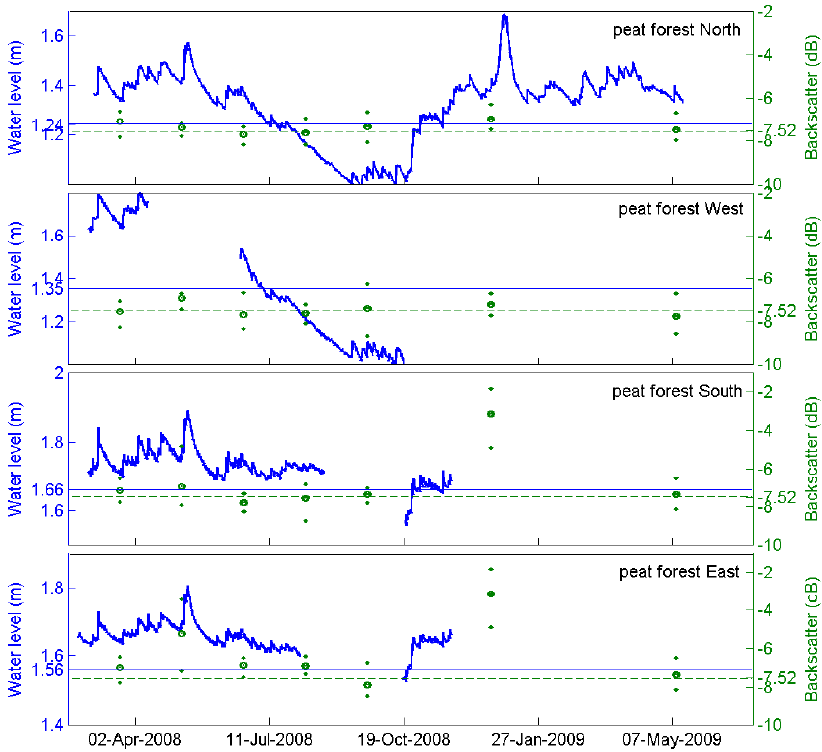
Fig. 14. Water level and radar backscatter return values obtained from a block of nine pixels at the water level gauge locations in the peat forest near Lake Melintang. Blue lines indicate ground levels at the gauge locations. Water levels are with respect to the subterrain position of each pressure sensor. Green circles, upper and lower dots indicate mean, maximum and minimum backscatter values, respectively. The dashed green line indicates the ground level for the radar backscatter return.